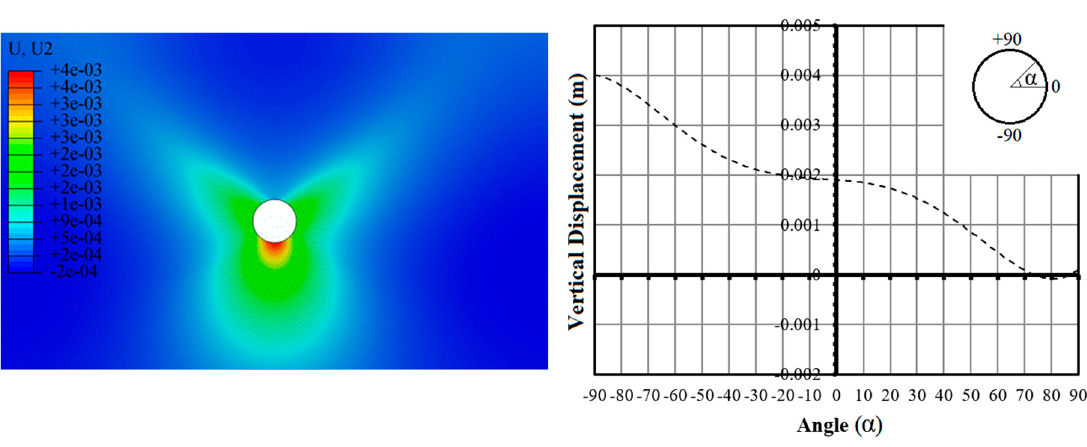
Figure 10. Stresses in the pipe wall under no-flow conditions (MPa).